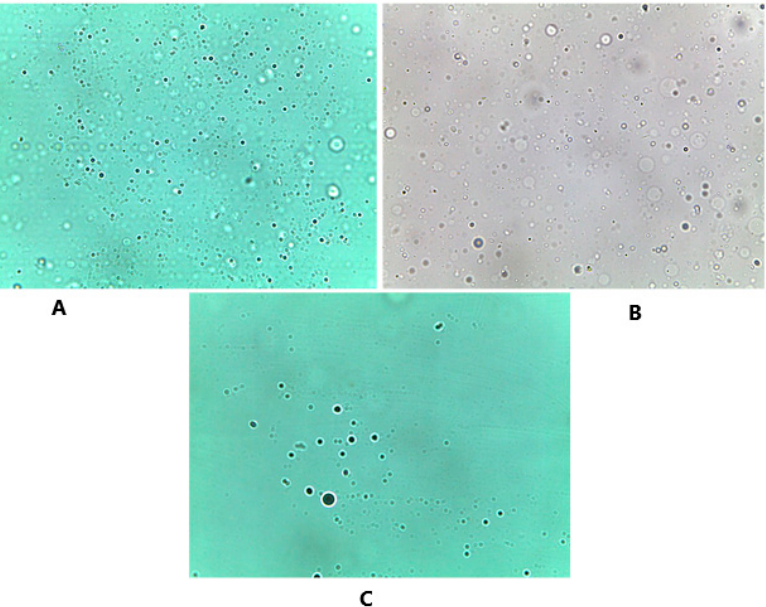
Figure 6. Optical microscope images that show the spherical shape of the formed niosomes after hydration, and the distribution of these niosomes. The three different carriers were examined under the microscope accordingly. ( A ) Glucose niosomes (FN1) Magnificatin (Mag) = 20 X, ( B ) maltodextrin niosomes (FN2) Magnification (Mag) = 20 X, ( C ) mannitol niosomes (FN3) Magnification (Mag) = 20 X.